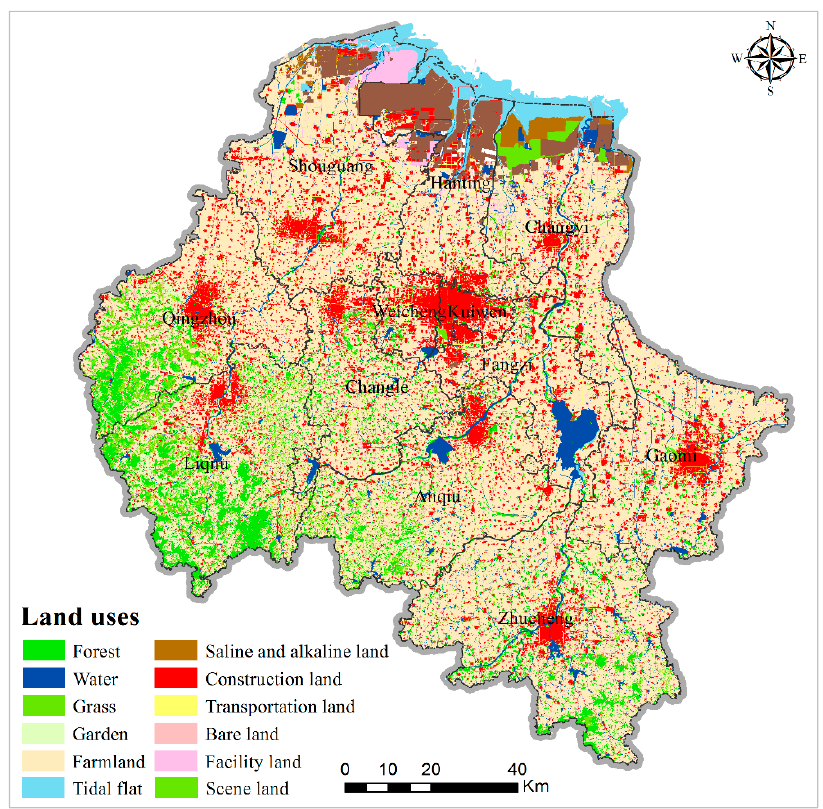
Figure 2. Spatial distributions of land uses in Weifang city.